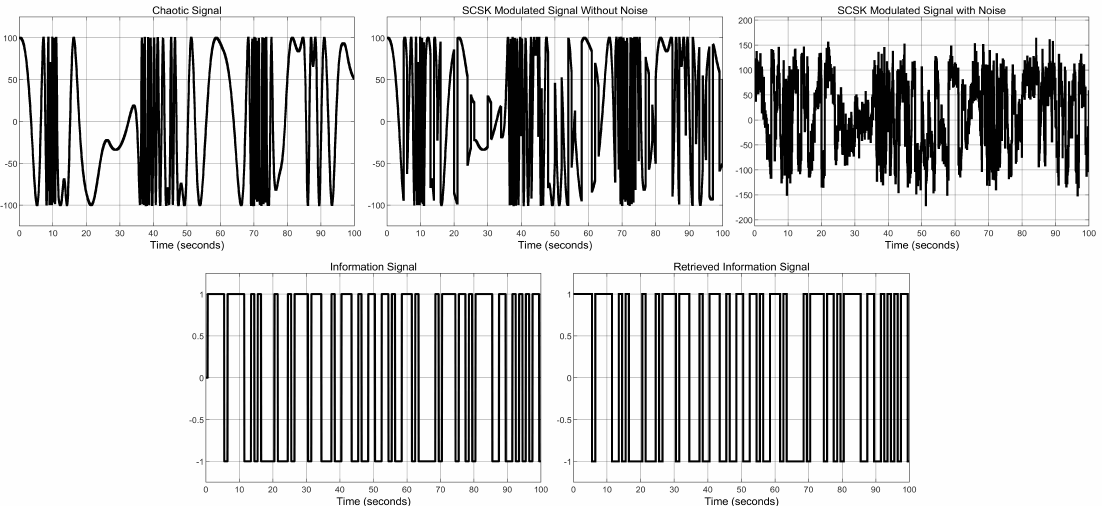
Figure 13. Simulation results of the SCSK secure communications design, for chaotic signal 100 · sin5 ( x + y + z ) .